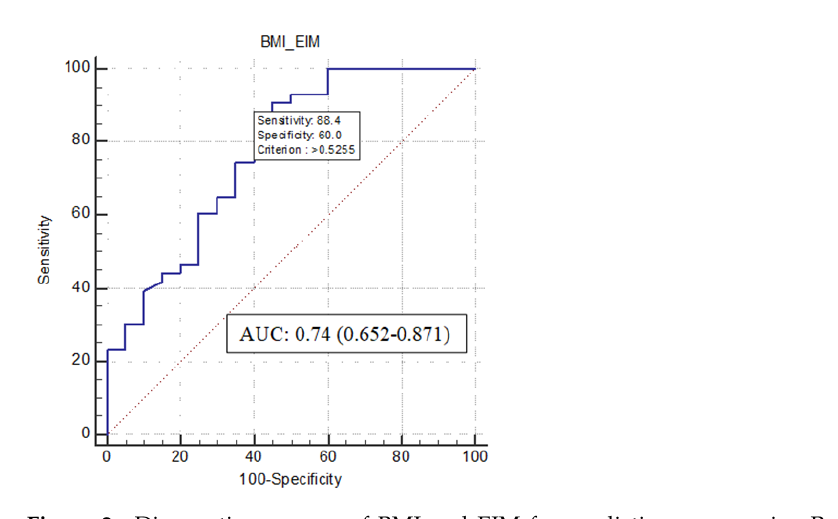
Figure 2. Diagnostic accuracy of BMI and EIM for predicting sarcopenia. Receiver Operating Characteristic curve to evaluate the sensitivity and specificity of the model to predict the presence of sarcopenia .